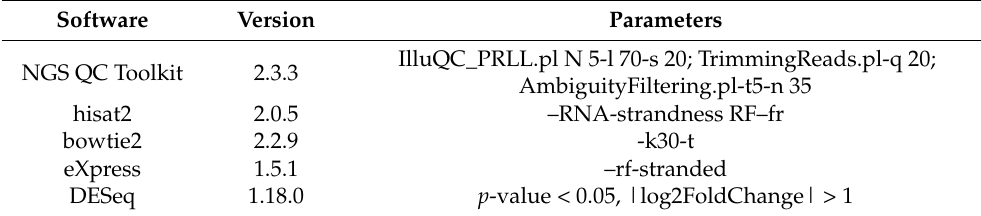
Table 1. RNA-seq analysis software and